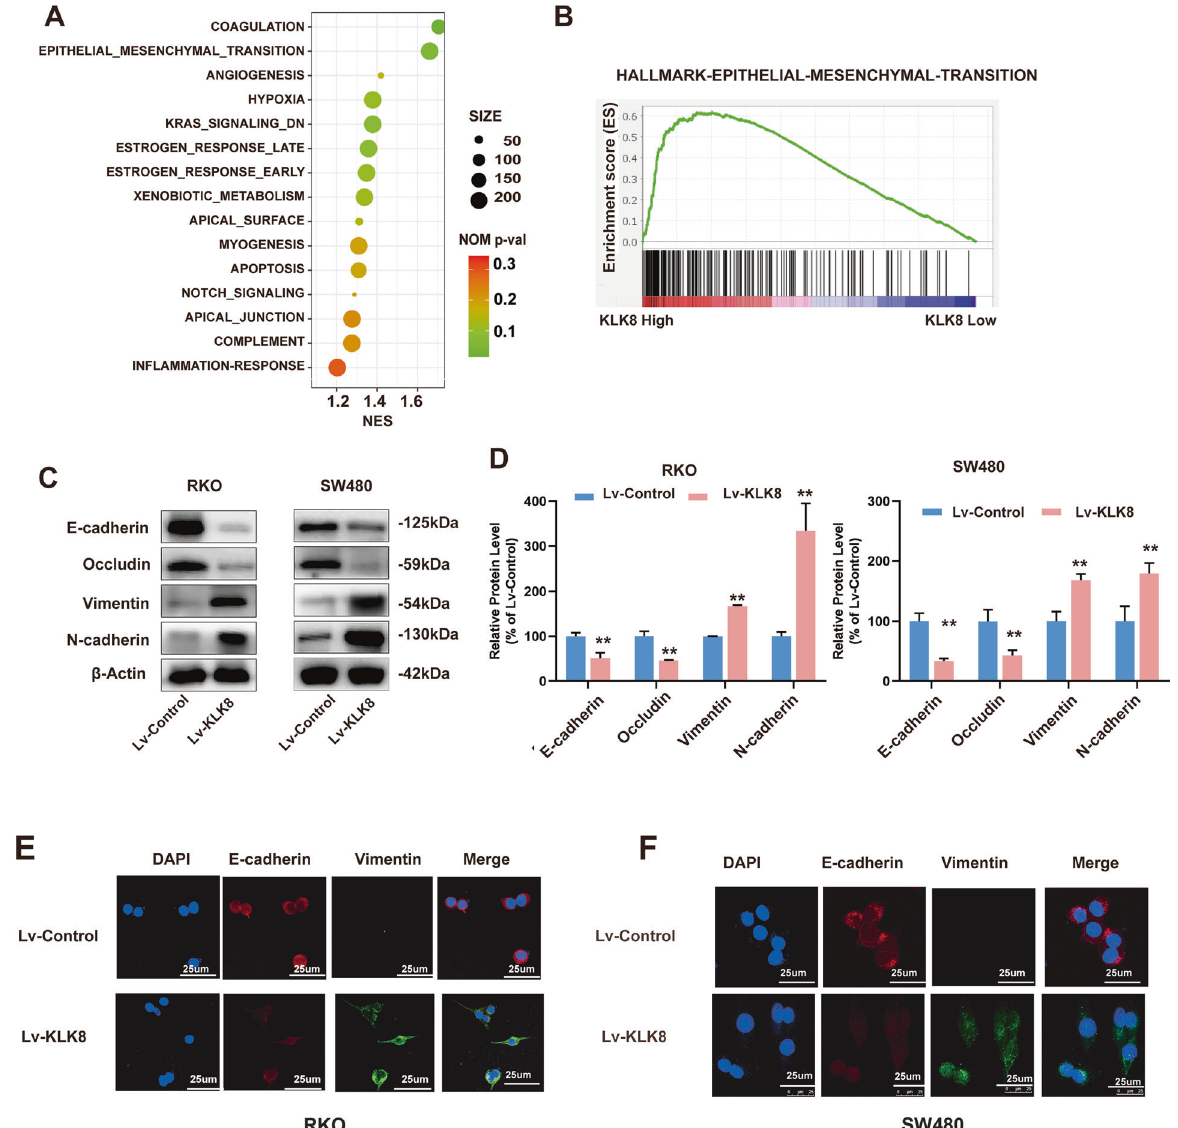
Fig. 5 KLK8 facilitated EMT in colon cancer cells in vitro. A Gene sets enriched in the transcriptional pro fi les of tumours belonging to the top KLK8 high-expression group, compared with the bottom-expression group in the TCGA dataset. Shown are the NES (normalized enrichment score) values for each pathway using the Hallmark gene sets. The functional annotations of KLK8-positive and -negative expression in CRC was predicted. B Positive correlation between colorectal cancer EMT and KLK8 expression was shown using the TCGA database ( n = 545). C Western blotting analysis showed that KLK8 decreased the expression levels of the epithelial cell markers E-cadherin and occludin and increased the mesenchymal markers N-cadherin and vimentin in KLK8-overexpression RKO and SW480 cells. D Quanti fi cation of the protein expression of E-cadherin, N-cadherin, vimentin and occludin represented in ( C ). E , F Immuno fl uorescence of E-cadherin and vimentin in RKO and SW480 cells overexpressing KLK8 or not. All of the data are presented as the mean ± SEM from three independent experiments. ** P <